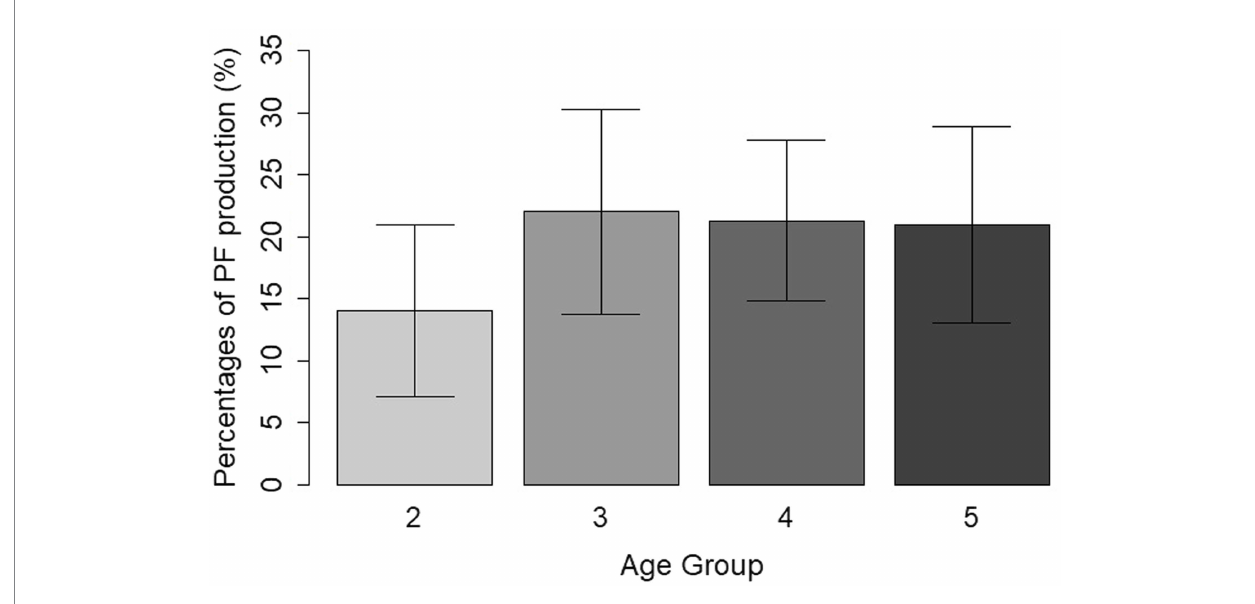
FIGURE 1 Percentages of PF productions by age